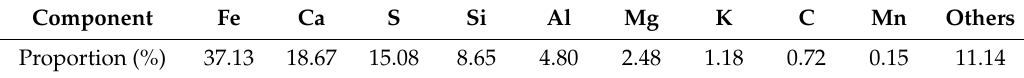
Figure 6. The particle size distribution of the sampled dust. Table 1. Composition of dust particles.